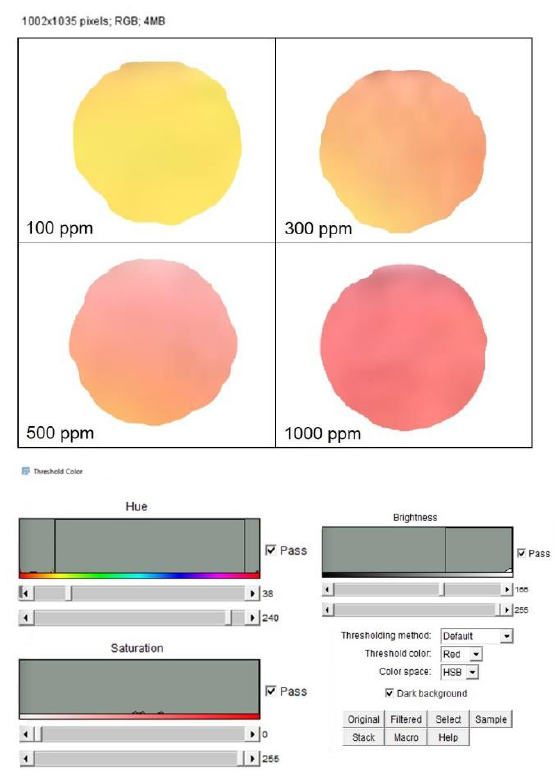
Figure 4. Hue adjustment section of the Threshold Color window in ImageJ of C 2 H 4 O PAD.